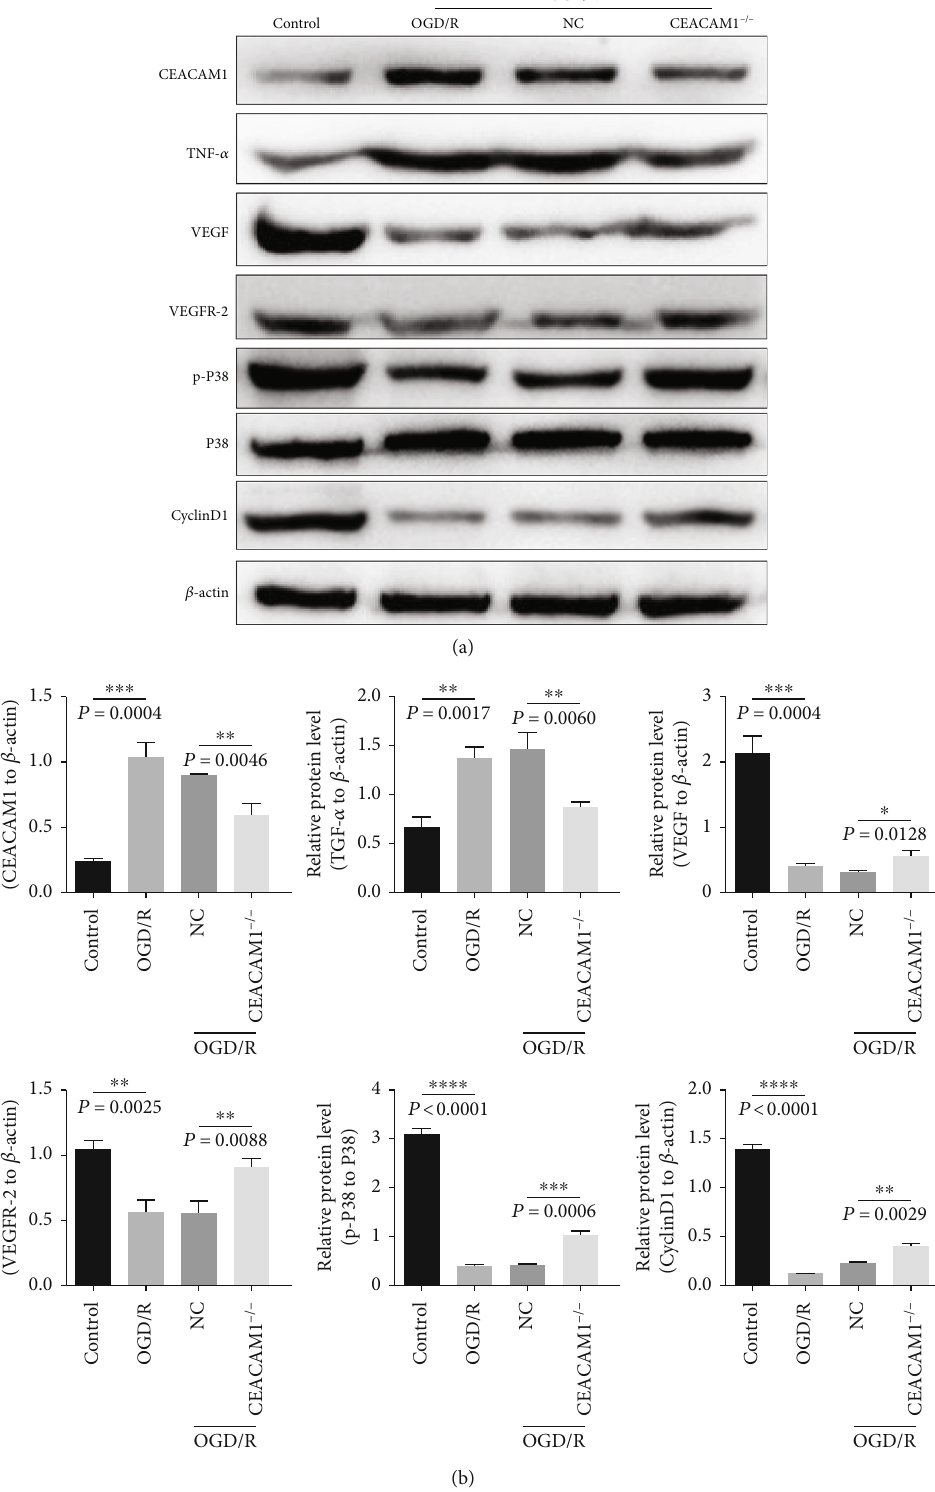
Figure 6: The protein levels of CEACAM1, TNF- α , VEGF, VEGFR-2, p-P38/P38, and CyclinD1 as detected by Western blot. (a) The expression level of CEACAM1, TNF- α , VEGF, VEGFR-2, cyclinD1, and MAPK phosphorylated were examined by Western blot in each group. (b) The expression level of CEACAM1 and TNF- α were higher while VEGF, VEGFR-2, CyclinD1, and MAPK phosphorylated were lower in the OGD/R group compared with control group; the expression level of CEACAM1 and TNF- α were reduced while VEGF, VEGFR-2, CyclinD1, and MAPK phosphorylated were increased in the CEACAM1 -/- group compared to the NC